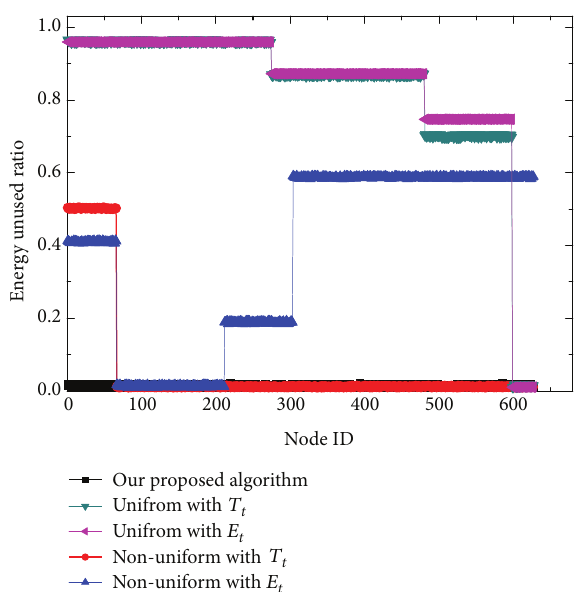
expected. Because of the imbalance consumption of energy near the sink, the uniform distribution has the shortest network lifetime. The nonuniform distribution combined with 𝑇 𝑡 achieved a shorter network lifetime than with 𝐸 𝑡 , because its average energy consumption is larger than in 𝐸 𝑡 scheme. Our algorithm can achieve the optimal energy consumption among the whole working nodes, thus having the longest network lifetime.